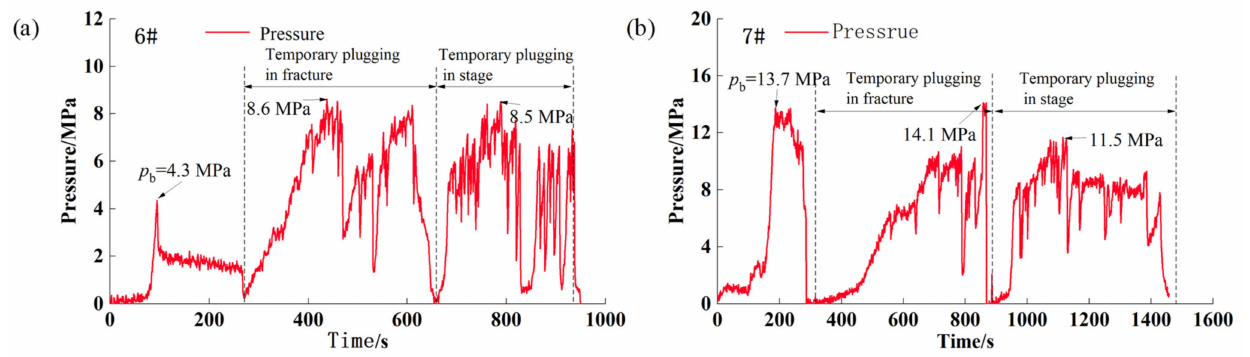
Figure 8. Temporary plugging pressure curve under different temporary plugging agent concentra- tions: ( a ) Pressure curve of specimen 6#; ( b ) Pressure curve of specimen